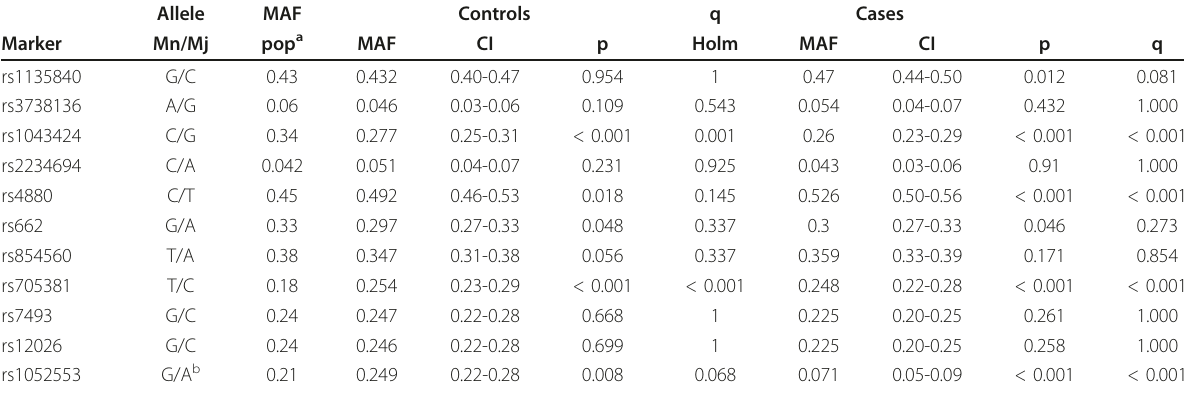
Table 3 Allele Frequencies of SNPs vs. General